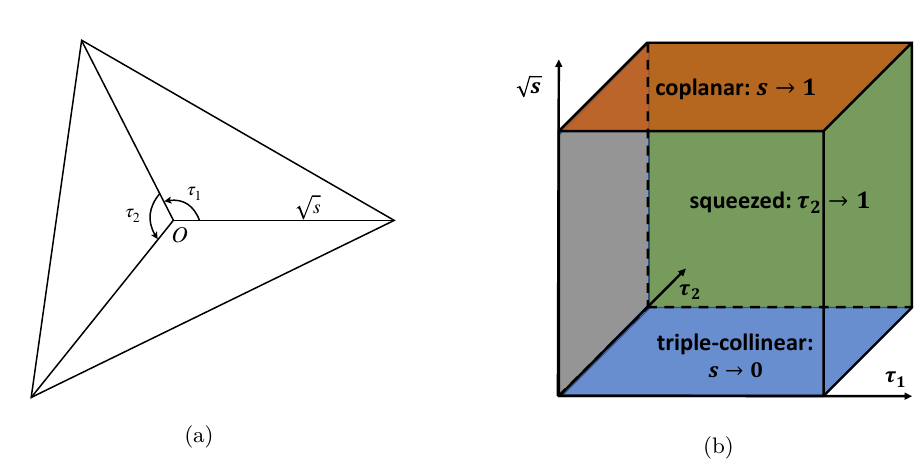
Figure 6 . (a) A graph on the { s, τ 1 , τ 2 } coordinate on the celestial sphere [5]. (b) The kinematic limits of EEEC under the { s, τ coordinate. s → 0 and s → 1 lead to the triple collinear and 1 , τ 2 } coplanar limit respectively, while τ 1 represents squeezed i →